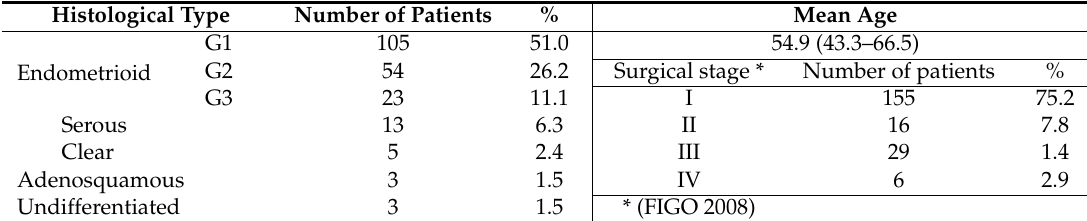
FIGO: International Federation of Gynecology and